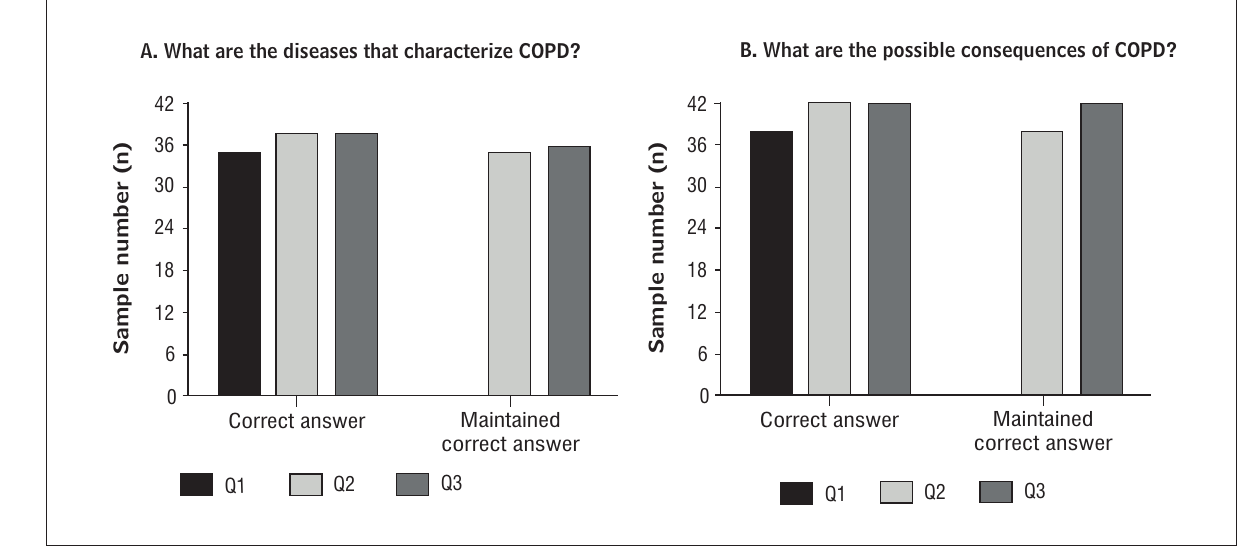
Figure 2 - Patients’ responses about the diseases that comprise COPD and the possible consequences of this pathology, respectively